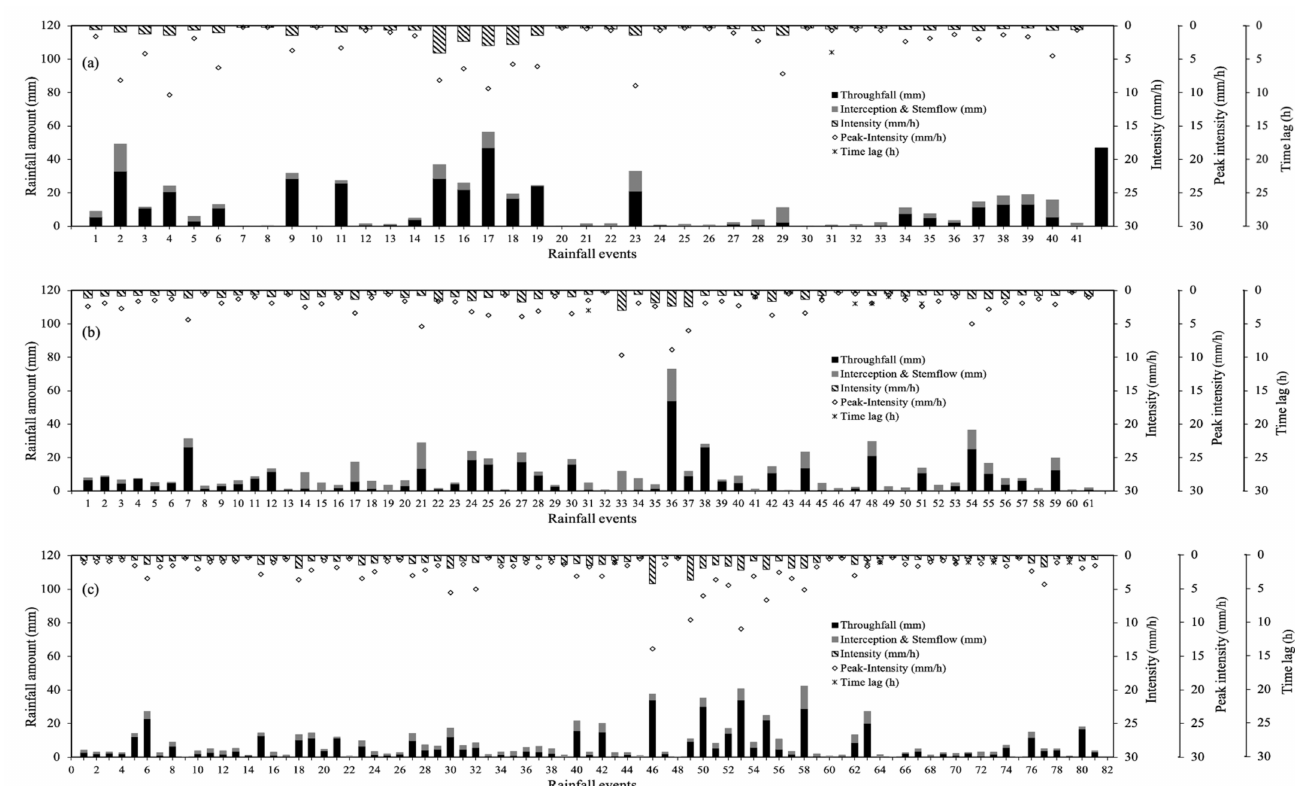
Figure 2. The rainfall amount ( P G ), average intensity ( In ), peak intensity ( In peak ), throughfall amount ( Tf ), and time lag of each event in CF ( a ), MF ( b ), and BF ( c